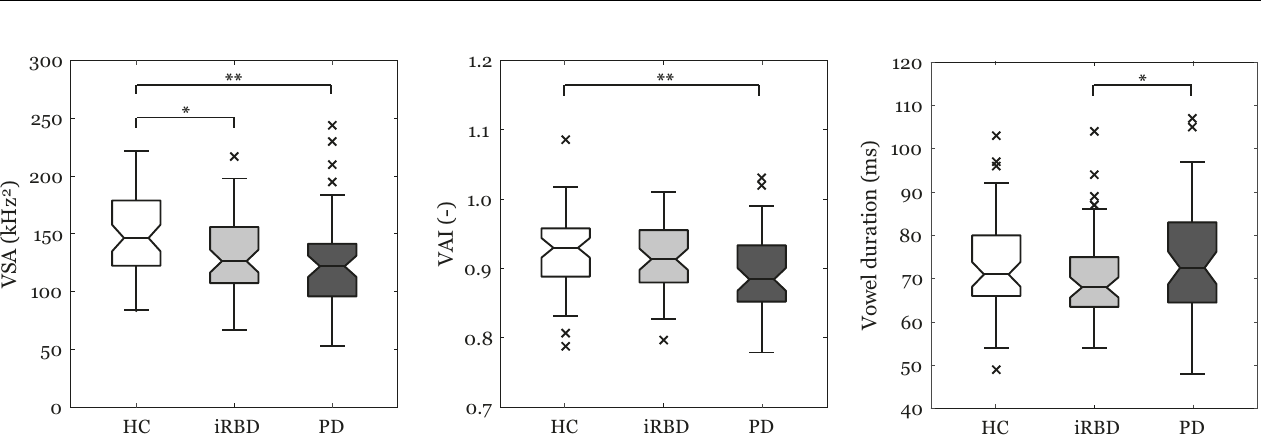
Fig. 1 Comparison of vowel measurements including VSA, VAI and vowel duration between HC, iRBD and PD using boxplots. The centre line indicates the median, and the bounds of the box indicate the 25th and 75th percentiles. The whiskers extend to the most extreme data points not considered outliers, and the outliers are plotted individually using the ‘ x ’ symbol. VSA, vowel space area, VAI vowel articulation index, “ Asterisks ” indicate signi fi cant differences after Bonferroni correction: * p < 0.05; ** p <